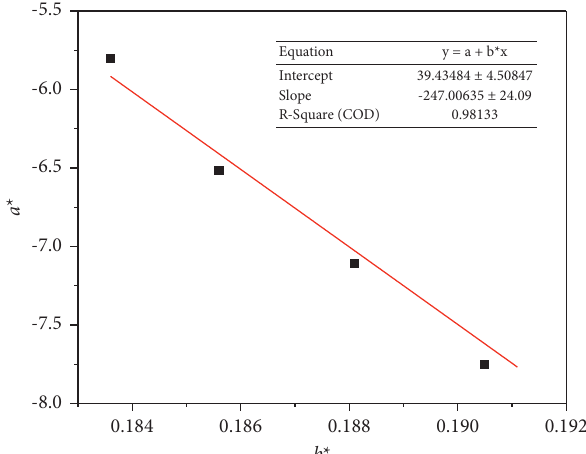
Figure 6: Graph of the supercorrelation ratio ( a ∗ vs. b ∗